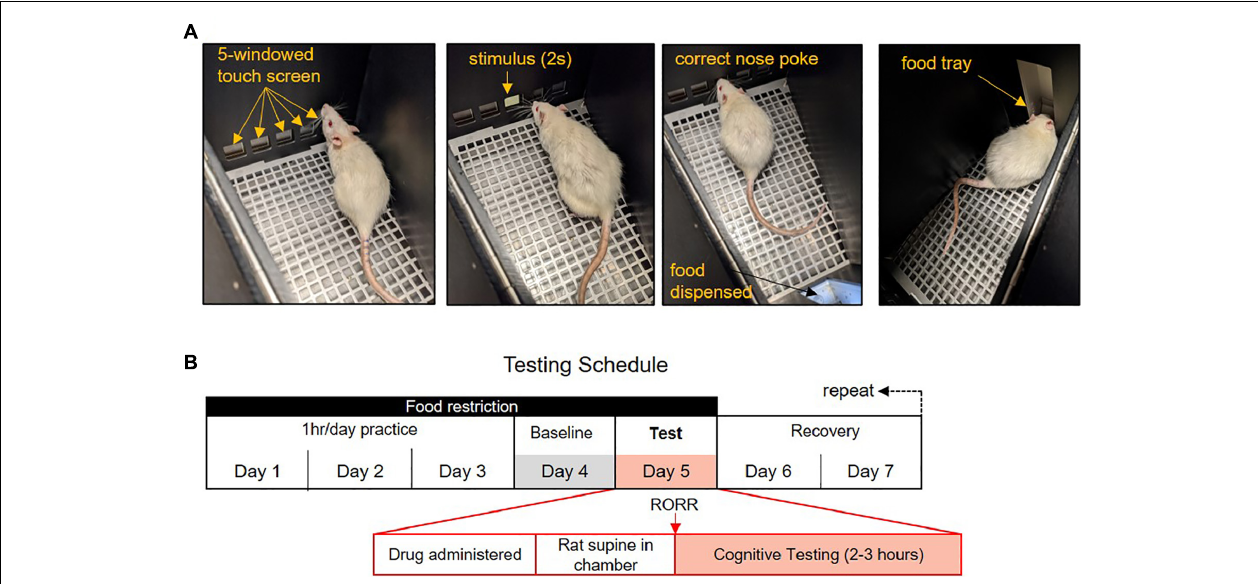
FIGURE 1 | The 5-choice Serial Reaction Time Task (5-CSRTT) testing paradigm. (A) In the 5-CSRTT rats attend a five-windowed screen for the presentation of a 2-s stimulus. Rats have 5 s to make a response. Correct responses are rewarded with a food pellet. Trials are initiated with a nose-poke to the food tray. (B) Anesthetic testing and food restriction schedule. Rats practice the task 4 days a week for an hour each day. Performance on the fourth day is used as the baseline comparison. On the fifth day, rats are exposed to an anesthetic regimen and placed supine in the testing chamber. Following the return of the righting reflex (RORR), rats may work on the 5-CSRTT for 2–3 h. Rats are given 2 days rest following anesthesia with free food access.